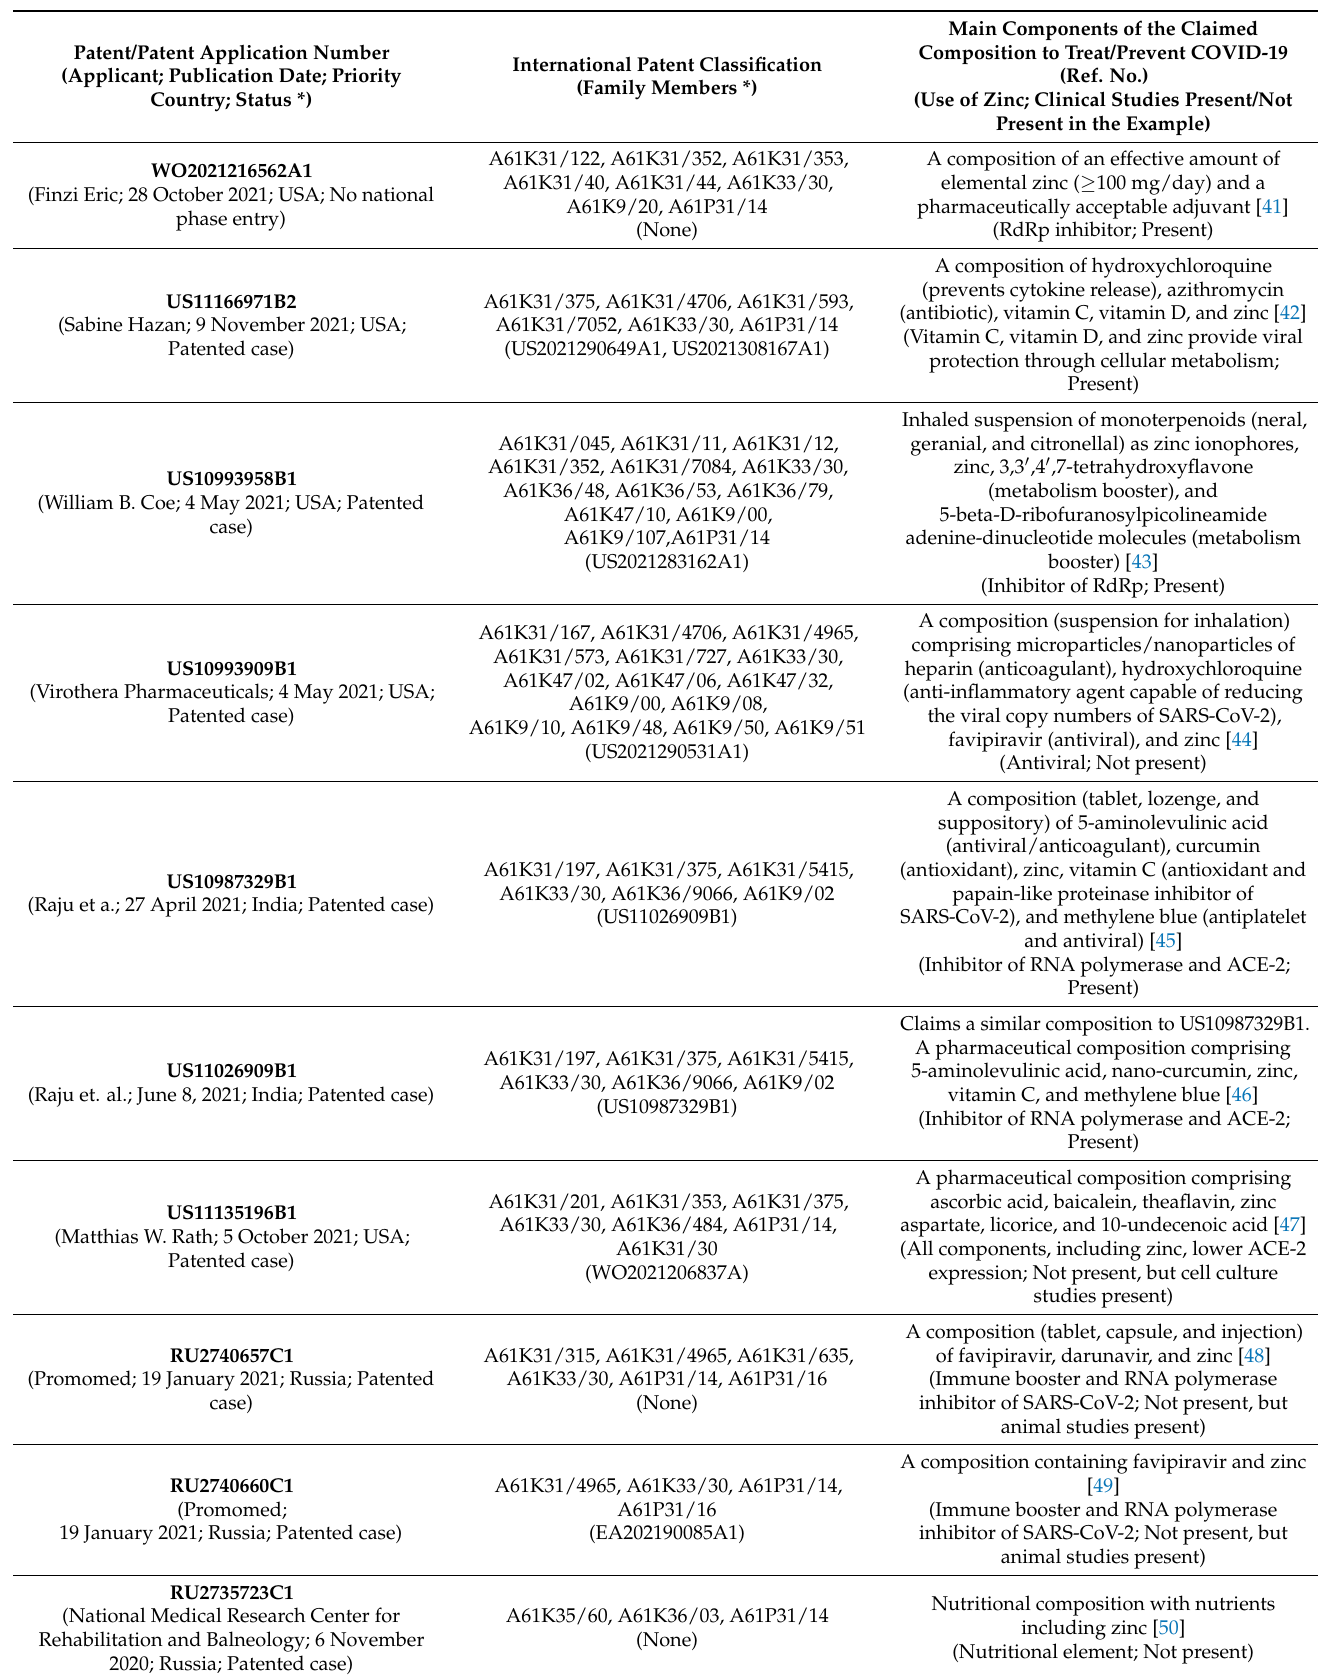
Table 4. Summary of the patent